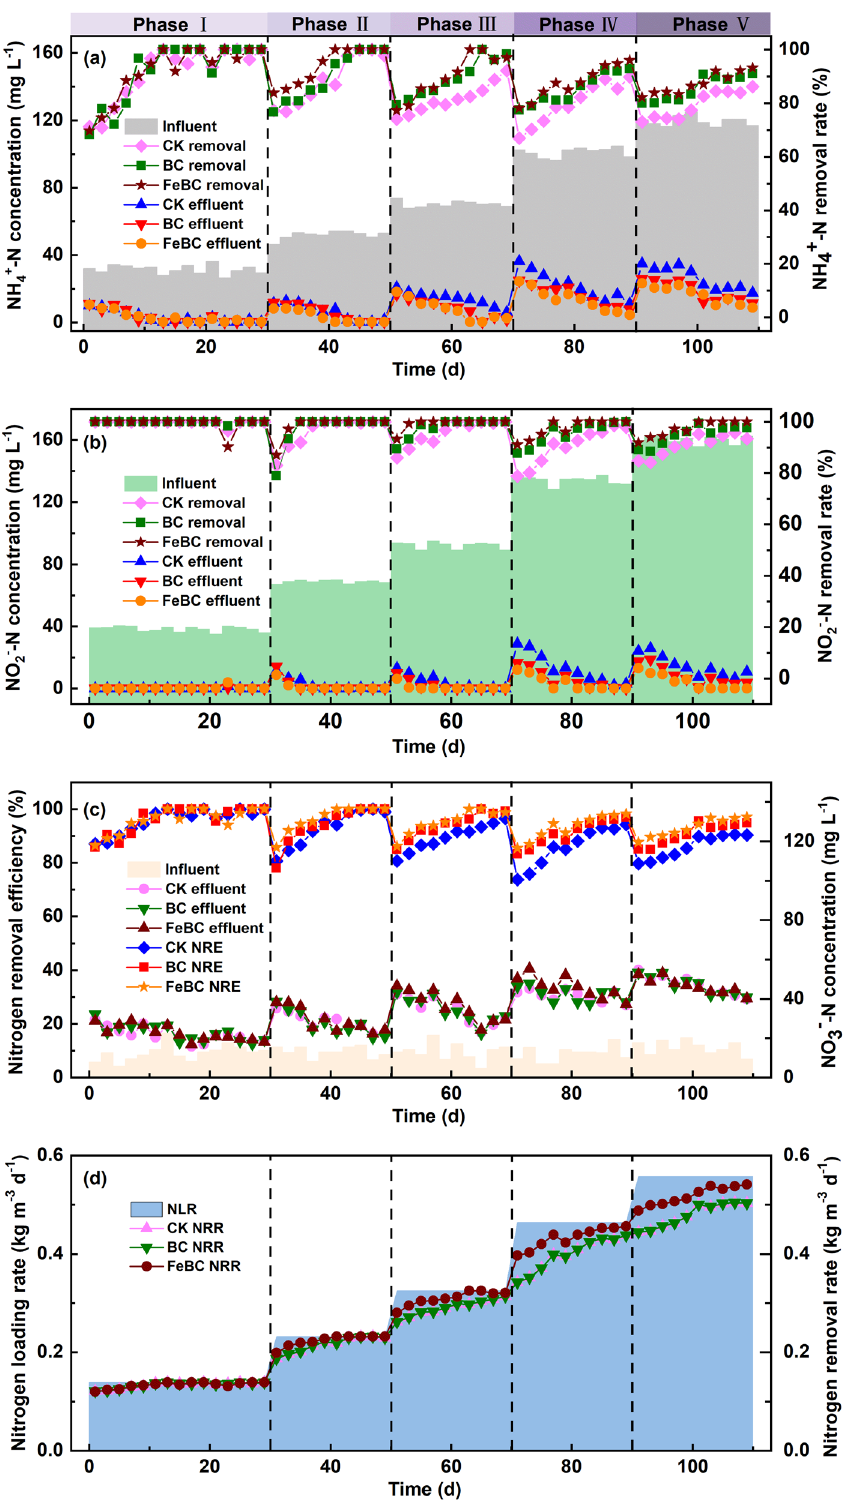
Fig. 3 Nitrogen removal performance of the anammox system with the increased nitrogen loading rate (NLR). a variations of NH 4 + -N concentrations; b variations of NO 2 − -N concentrations; c variations of NO 3 − -N concentrations and NRE; d NRR and NLR. CK, BC and FeCK represent the anammox system without biochar, Enteromorpha prolifera and iron-modified Enteromorpha prolifera biochar additions,